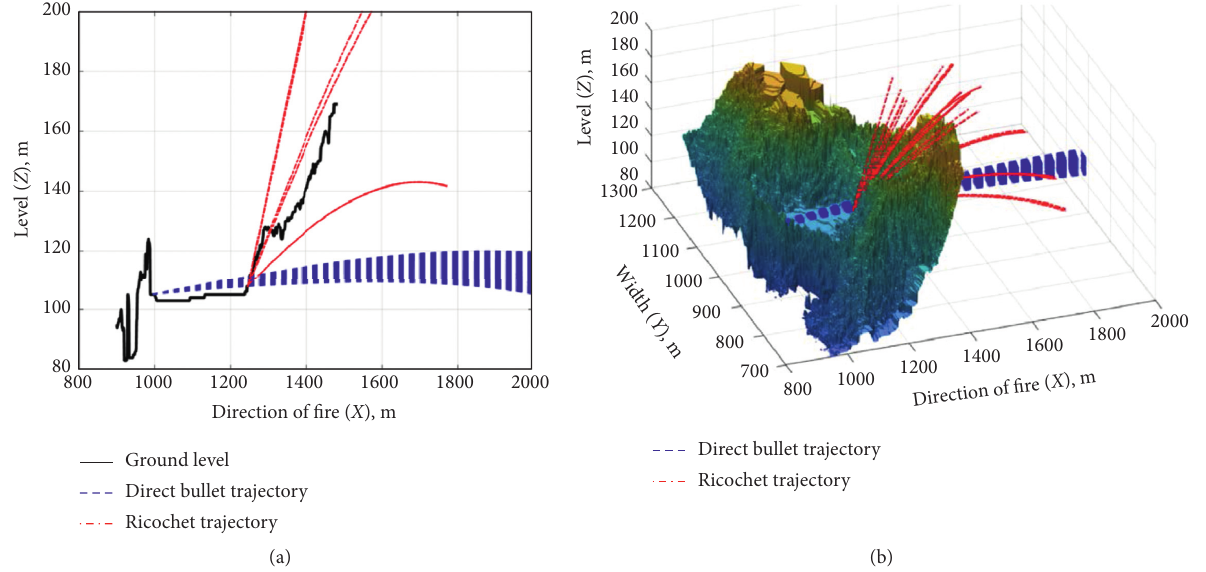
Figure 10: Bullet trajectory curves with topographic data (1,000 fires of K2 rifle and K100 bullet with 49MOA). (a) 2D section and (b) 3D